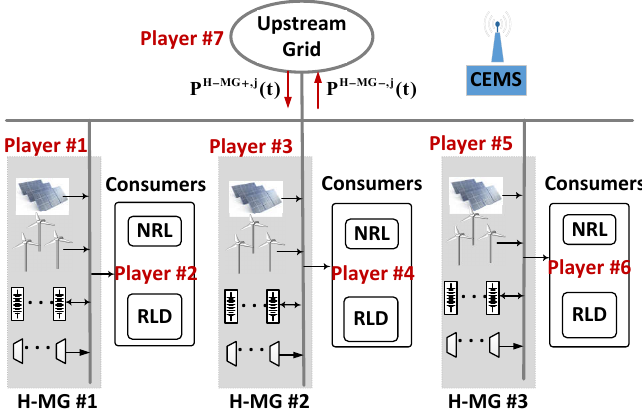
Figure 6. The network under study.